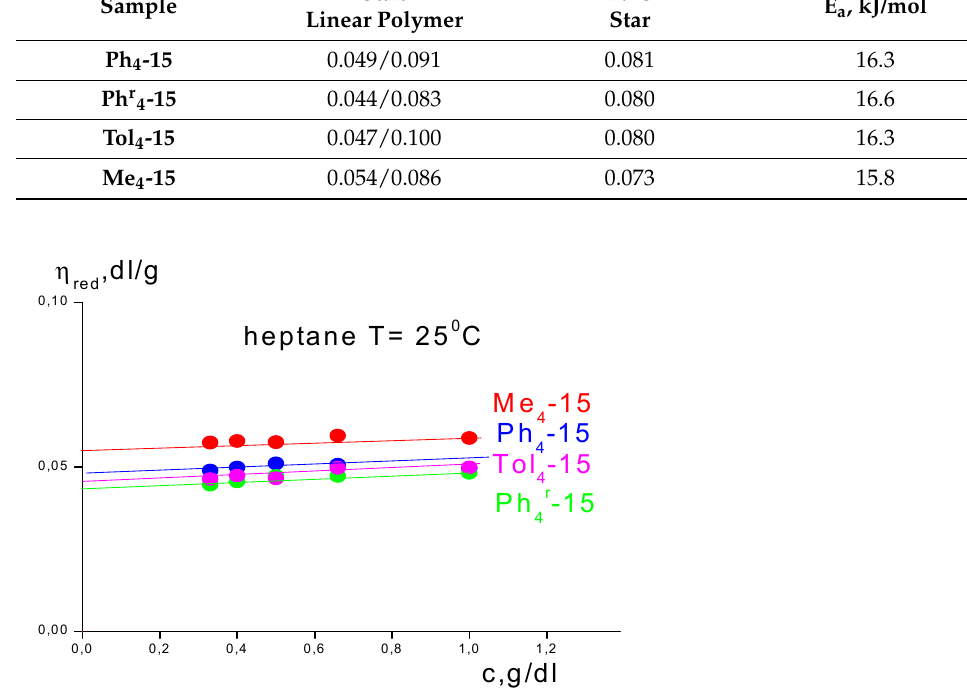
Figure 6. Concentration dependences of reduced viscosity of dilute solutions of star-shaped Ph r 4 -15 , Me 4 -15 , Ph r 4 -15 and Tol 4 -15 in heptane.